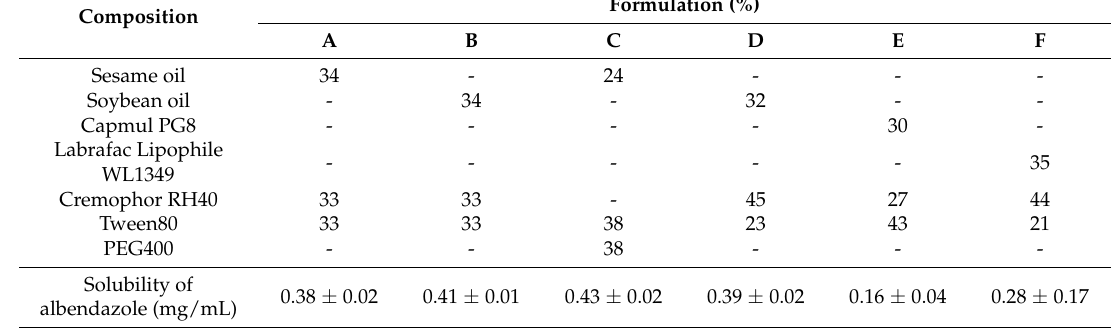
Table 3. Solubility of albendazole in selected self-microemulsifying formulations.